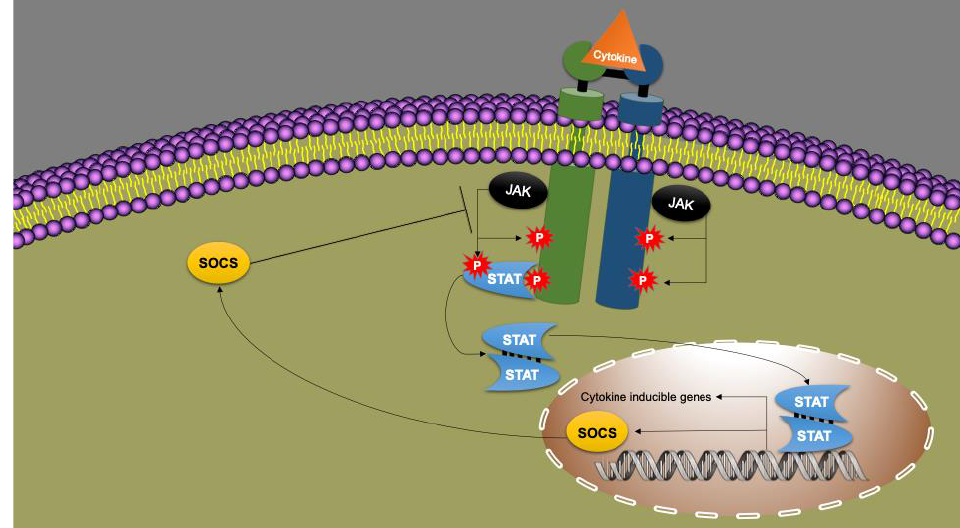
Figure 3. Cytokine signaling via the JAK/STAT pathway. A cytokine, such as leptin, binds to its receptor on the plasma membrane. The cytokine receptor is associated with the Janus kinase (JAK; “Just Another Kinase”). JAK phosphorylates two receptor tyrosines, after which JAK is recognized by STAT (Signal Transducer and Activator of Transcription). Subsequently, STAT is also phosphorylated by JAK. Two phosphorylated STATs form a dimer. The STAT dimer acts as a transcription factor. It binds to the promoter parts of genes affected by that cytokine (“target genes”). These genes are then transcribed into mRNA (DNA to mRNA) and translated into proteins (mRNA to protein). Proteins expressed via this JAK/STAT pathway have functions in proliferation, differentiation, growth and apoptosis. Together they form the products of the “Cytokine Inducible Genes” (CIG). Suppressor Of Cytokine Signaling (SOCS) is also a CIG product. SOCS inhibits the JAK/STAT pathway and thus cytokine signaling. This creates a negative feedback loop. Modified from Morris, Kershaw and Babon [147].